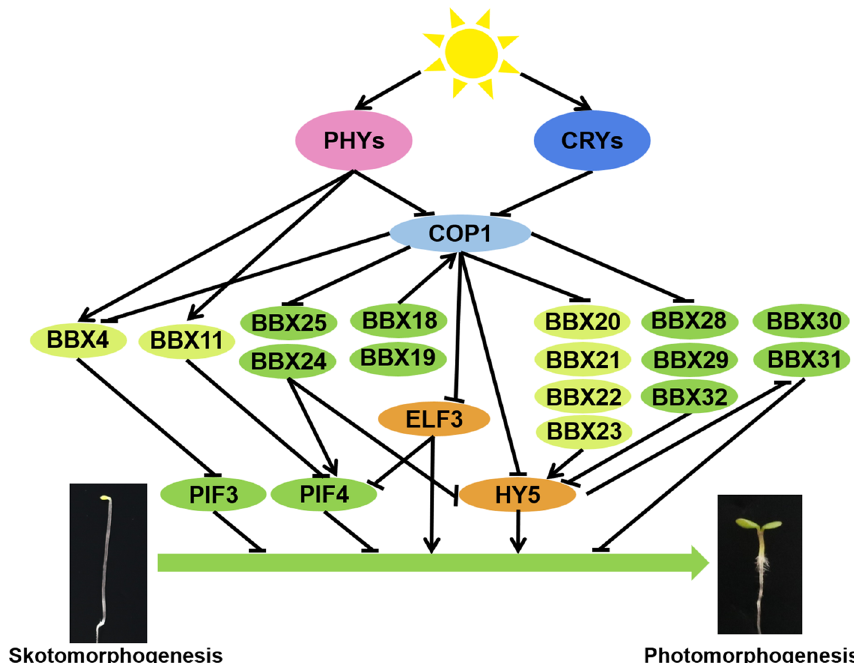
Fig. 2 BBX proteins in plant photomorphogenesis. PhyB interacts with BBX4 to promote its accumulation, the accumulated BBX4 interacts with PIF3 to repress its transcriptional activation activity. BBX11 interacts with phyB which enhances the interaction between phyB and PIF4, leading to improve the degradation of PIF4 and promote photomorphogenesis in the prolonged red light. In addition, BBX11 interacts with PIF4 to repress the binding ability of PIF4 to its targets which further contributes to enhance plant photomorphogenesis. BBX18 and BBX19 associate with COP1 to elevate its E3 ubiquitin ligase activity towards ELF3. COP1 targets BBX20, BBX21, BBX22, BBX23, BBX24, BBX25, BBX28 and BBX29 for